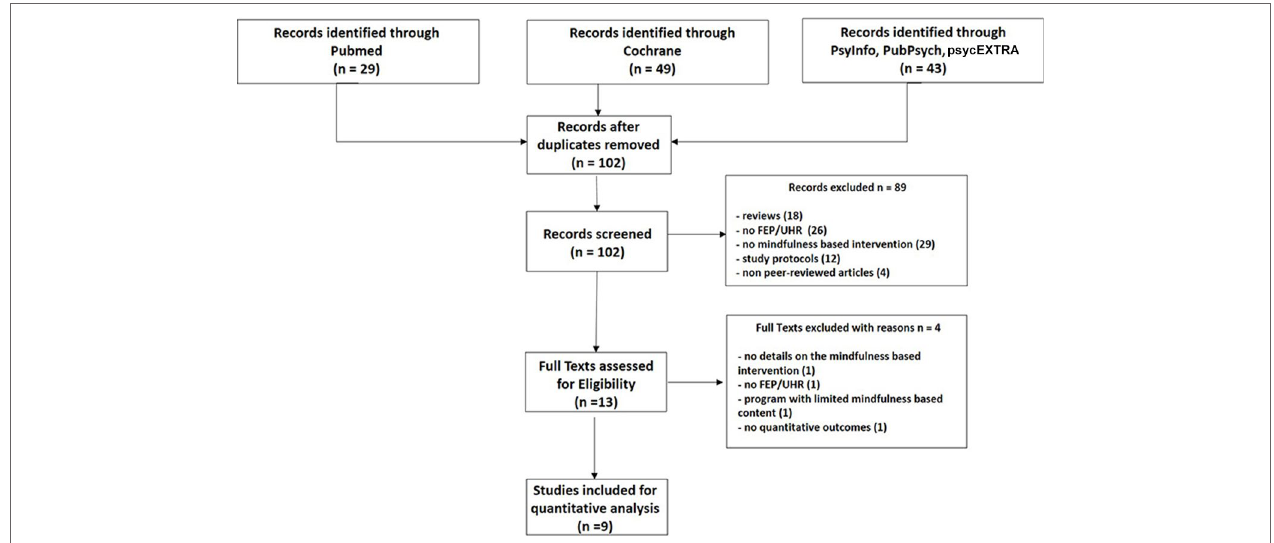
FIGURE 1 | PRISMA (Preferred Reporting Items for Systematic Reviews and Meta-Analyses) flow diagram.